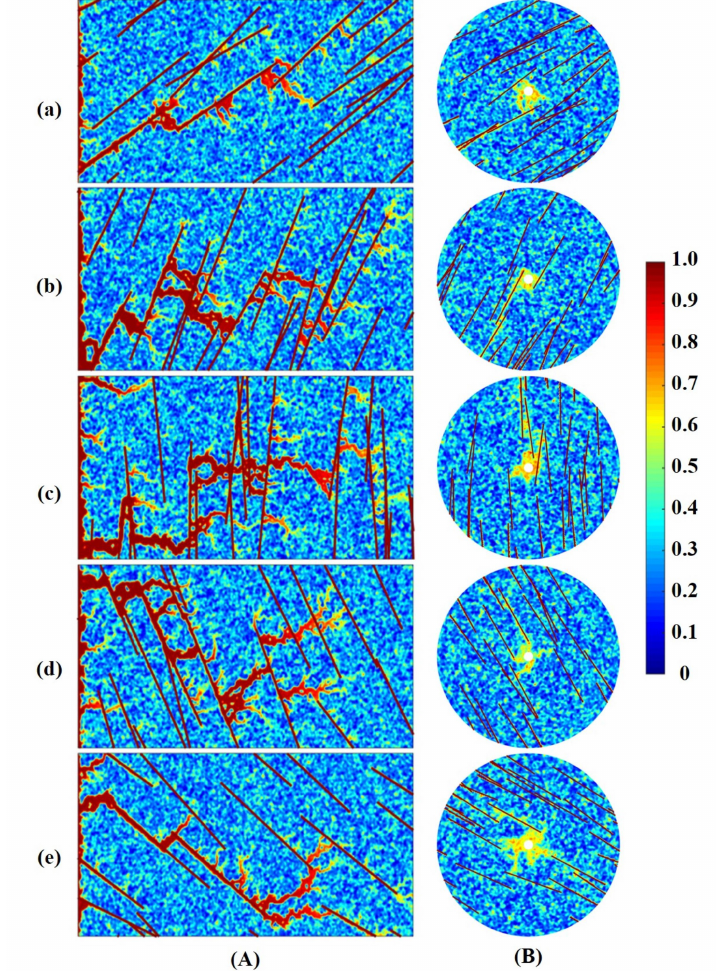
Figure 1. Porosity fields show the impact of fracture orientation on wormhole structures ( A ) Linear case, ( B ) Radial case and at different fracture dips: ( a ) 30 ◦ , ( b ) 60 ◦ , ( c ) 90 ◦ , ( d ) 120 ◦ ( − 60 ◦ ), ( e ) 150 ◦ ( − 30 ◦